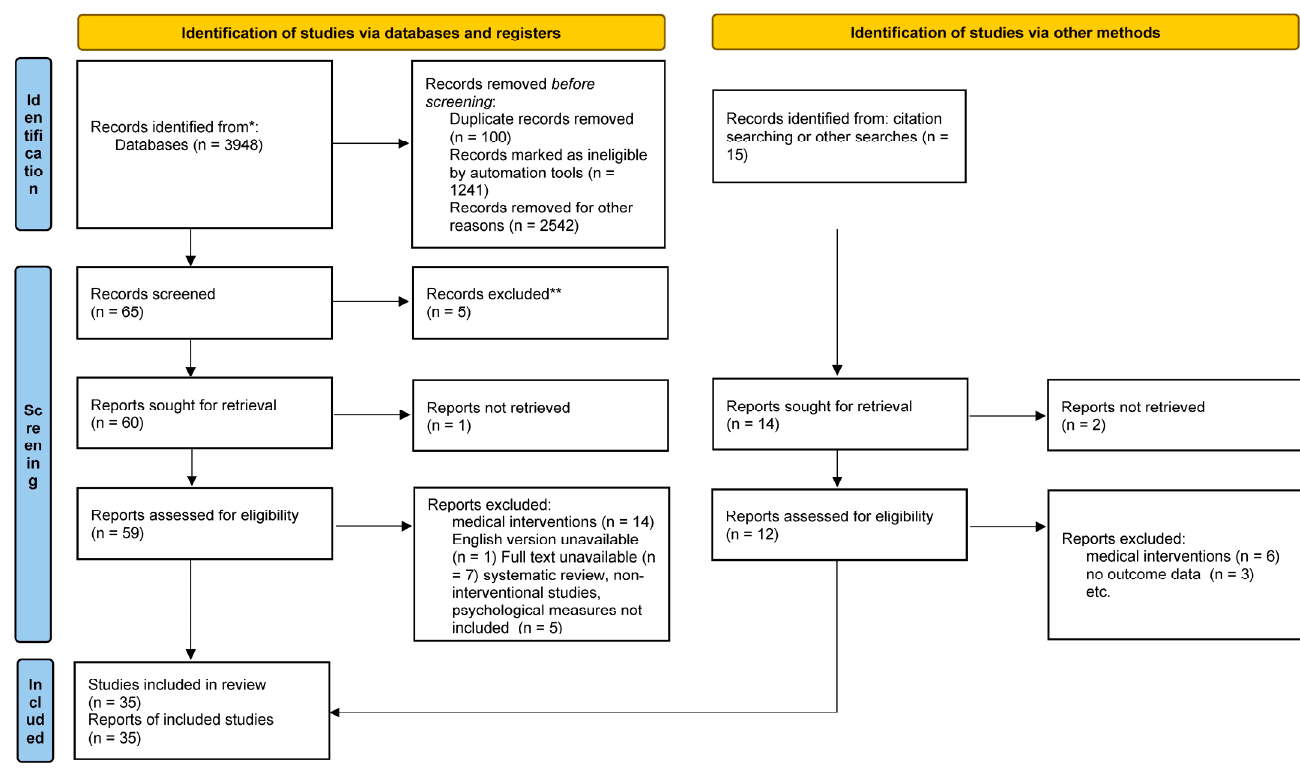
Figure 1. PRISMA 2020 flow diagram for new systematic reviews which included searches of databases, registers and other sources. (PRISMA 2020 statement, https://www.prisma-statement.org// (accessed on 7 October 2022).